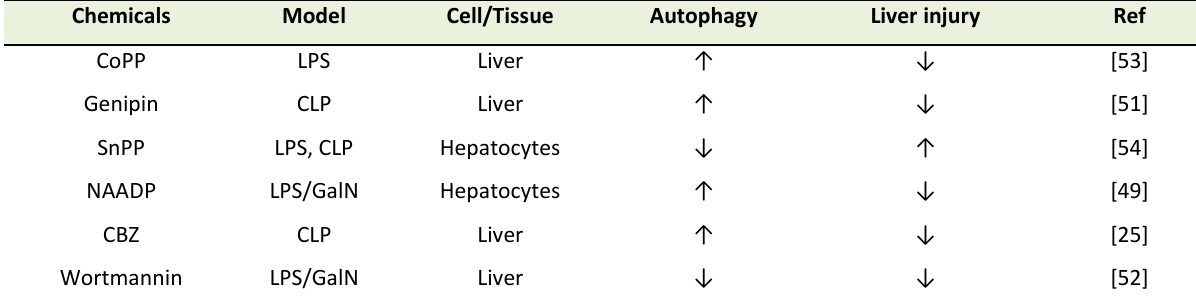
Table 1. Chemicals that affect liver injury during sepsis by modulating autophagy.